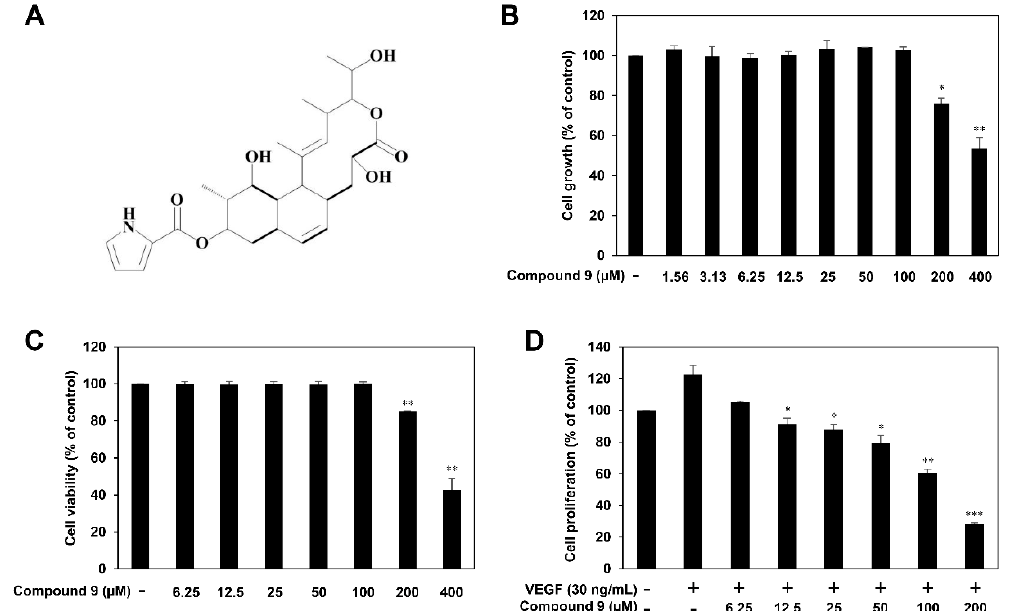
Figure 1. ( A ) The chemical structure of 23-demethyl 8,13-deoxynargenicin (compound 9 ). ( B , C ) The cytotoxic e ff ect of compound 9 on HUVECs. Cells were treated with the indicated concentrations of compound 9 for 24 h. ( B ) Cell growth was measured by the MTT assay and the IC 50 value from obtained data was analyzed using the curve-fitting program GraphPad Prism 5. ( C ) Cell viability was measured by the trypan blue exclusion method. * p < 0.05, ** p < 0.01 vs. the control. ( D ) The antiproliferative e ff ect of compound 9 in HUVECs. Cells were treated with the indicated concentrations (6.25–200 µ M) of compound 9 in the presence of VEGF (30 ng / mL) for 72 h. * p < 0.05, ** p < 0.01, *** p < 0.001 vs. the VEGF control. Each value represents the mean ± SD from three independent experiments.